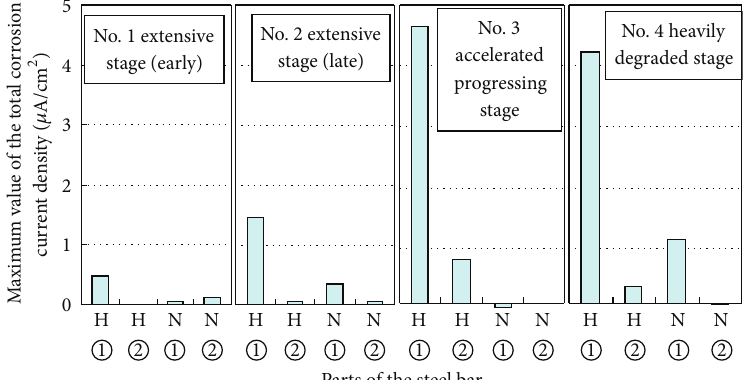
Figure 4: Average value of the total corrosion current density between each divided part in steel bars at various stages of corrosion